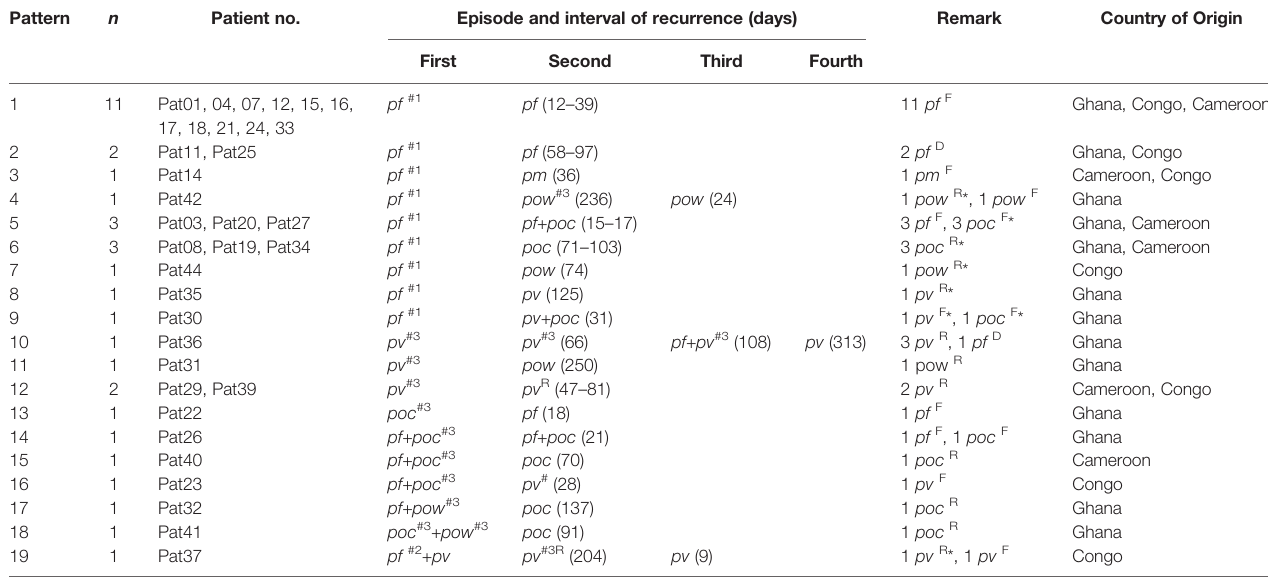
TABLE 1 | Recurrence patterns of the imported malaria cases.